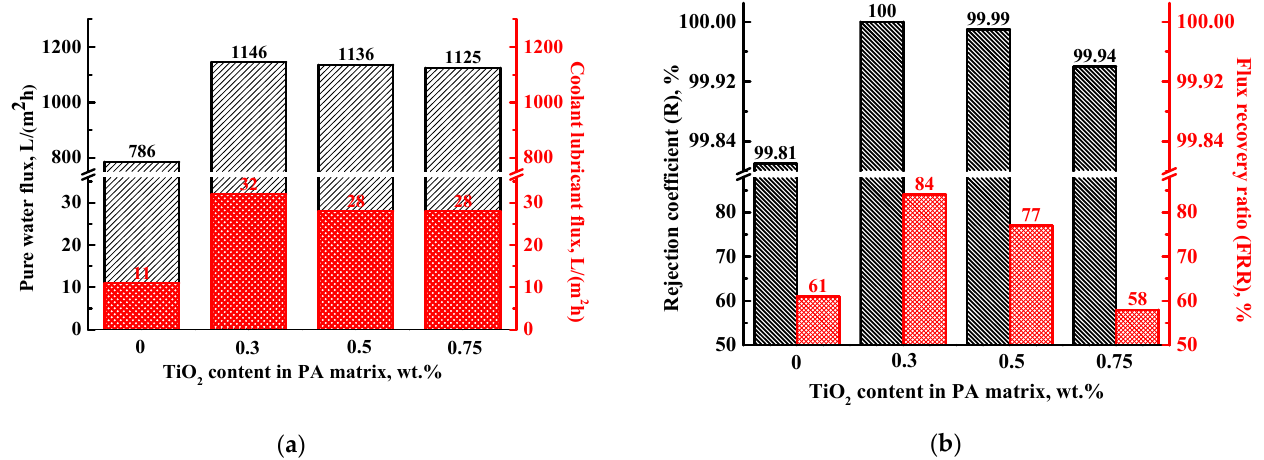
Figure 7. The dependence of ( a ) pure water and coolant lubricant fluxes, ( b ) rejection coefficient (R), and flux recovery ratio (FRR) on the TiO 2 content in the PA membranes.